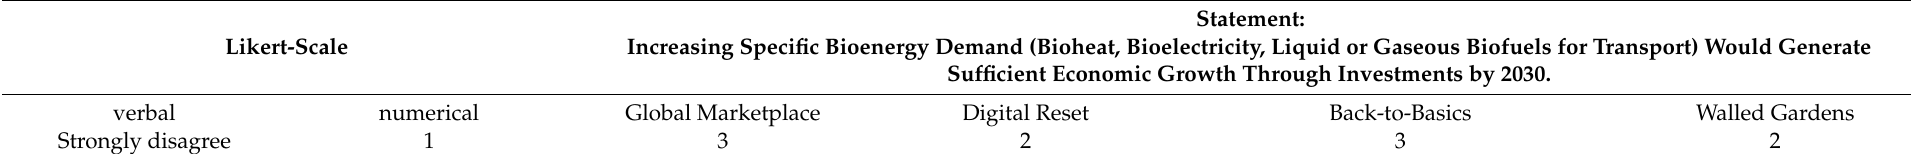
Table A5. Example of constituting consensus in experts’ opinion (consensus range represented by values in italics) and interpreting results.